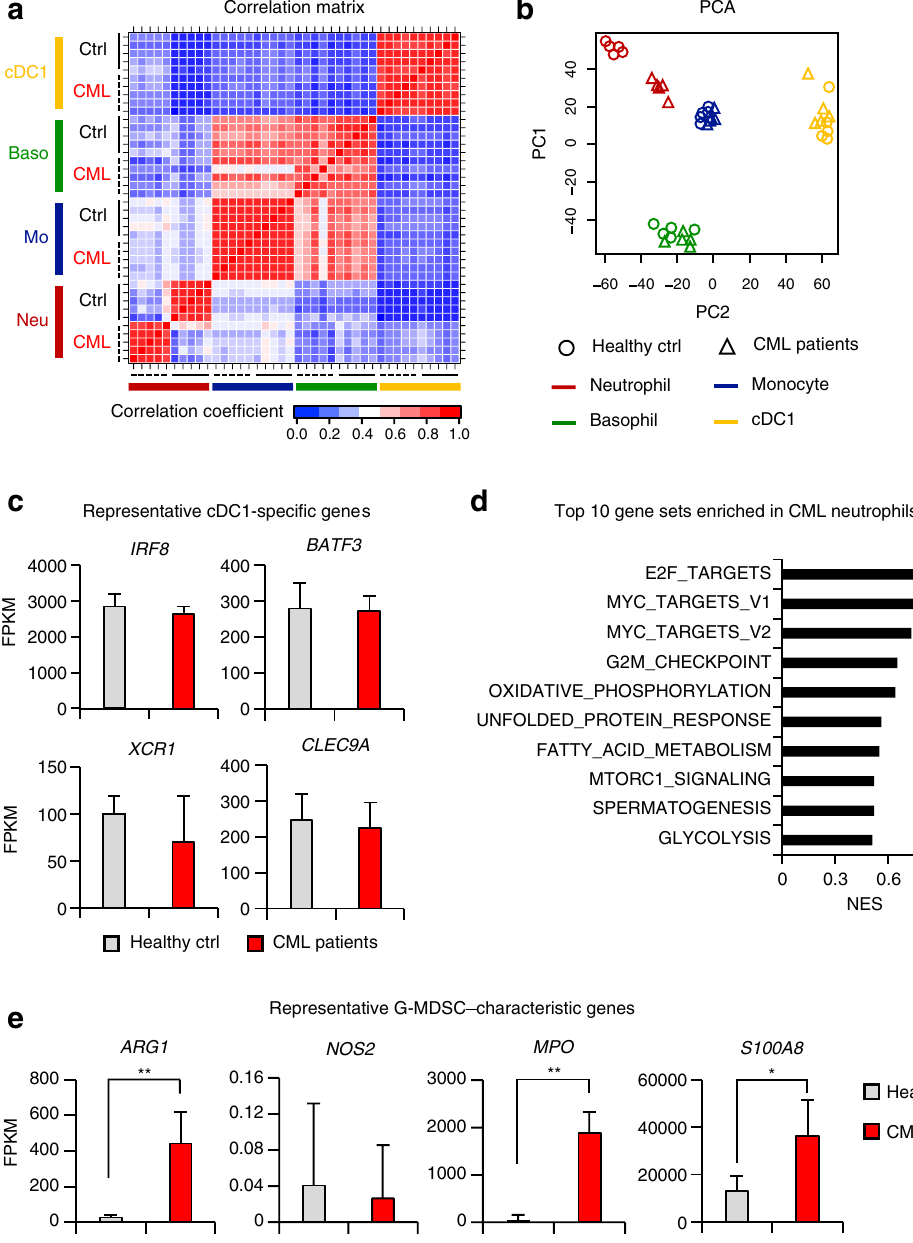
Figure 4. Transcriptomic analysis of myeloid cells in CML patients. ( a ) Pearson’s correlation coefficients of RNA-seq data between indicated cell populations (Healthy ctrl [Ctrl], n = 5; CML patients [CML], n = 5). Neu, neutrophils; Mo, monocytes; Baso, basophils; cDC1, type 1 conventional dendritic cells. ( b ) Principal component analysis (PCA) of RNA-seq data. ( c ) Expression of representative cDC1-specific genes in cDC1s from healthy ctrl and CML patients. ( d ) Normalized enrichment scores (NES) of top 10 gene sets enriched in neutrophils from CML patients compared to those from healthy ctrl identified using gene set enrichment analysis (GSEA). ( e ) Expression of representative G-MDSC–characteristic genes in neutrophils from healthy ctrl and CML patients. Values in ( c ) and ( e ) are the mean ± SD. * P < 0.05, ** P < 0.01 (Student’s t